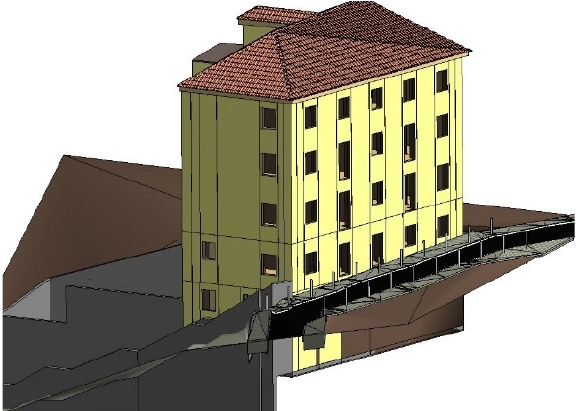
Figure 7. Complete architectural model and surrounding elements.